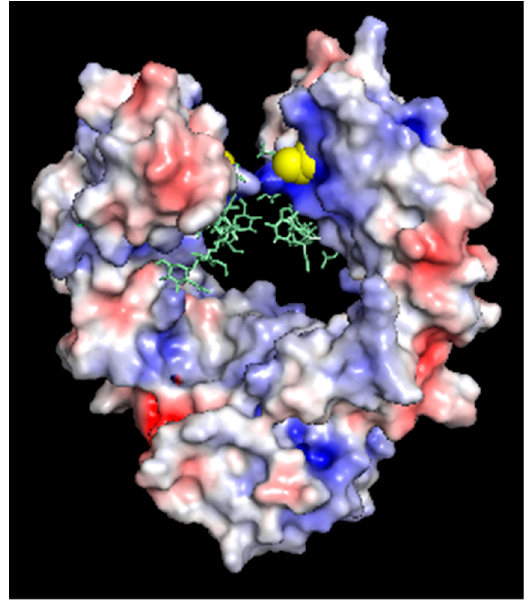
Figure 3. Electrostatic surface potential of Fc-C239i, calculated using the adaptive Poisson-Boltzmann program within Pymol. Glycans are added using cyan sticks, and the inserted Cys is emphasized with yellow spheres. Note the blue area (electropositive) around the C239i residue.